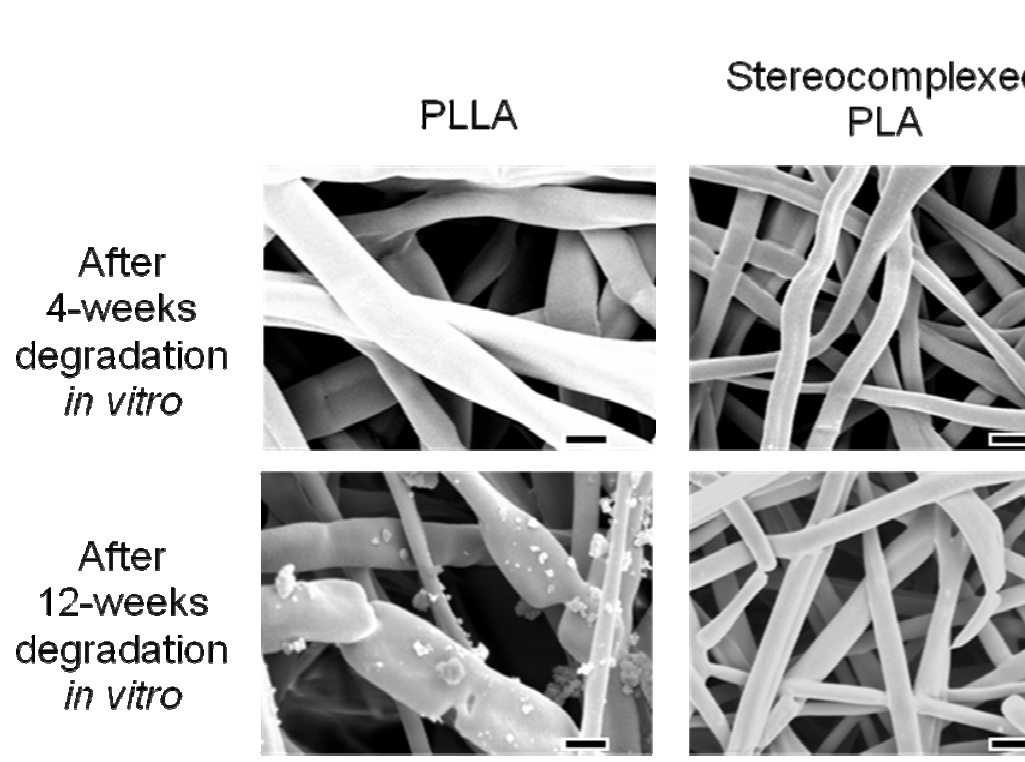
SEM images of PLLA (left) and stereocomplexed (right) nanofibers after 4-weeks (upper) and 12-weeks (lower) in vitro degradation in PBS. Scale bars = 1 μ m